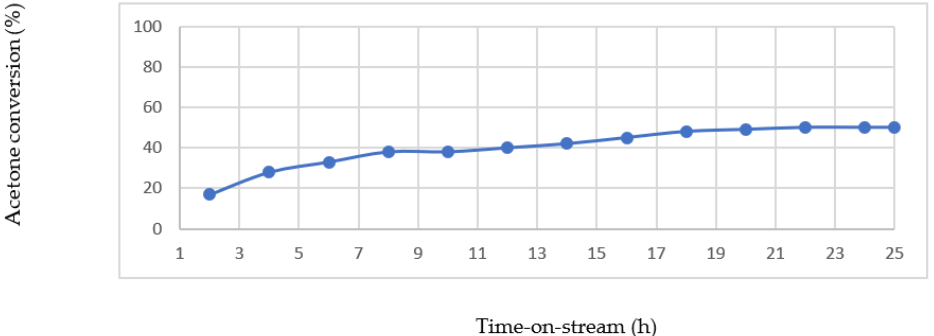
Figure 20. Catalyst lifetime test for as-synthesised Au-0.6M dp/SBA-15 catalyst in acetone complete oxidation at 270 °C .